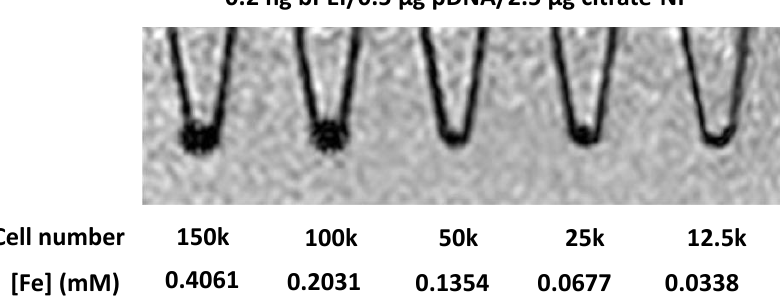
Cytotoxicity (U87MG)